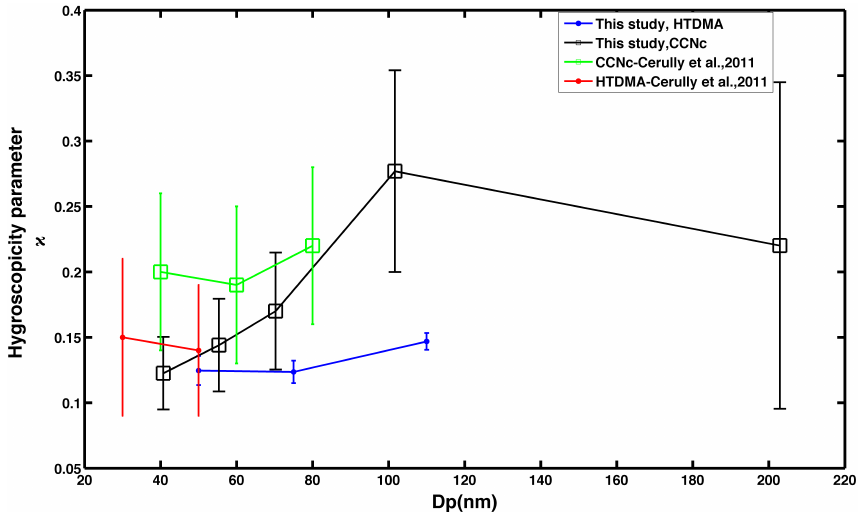
Fig. 5. Calculated κ values ( κ HTDMA and κ CCN ) as a function of particle dry diameter using HTDMA and CCNC measurements from this study and from the study by Cerully et al.